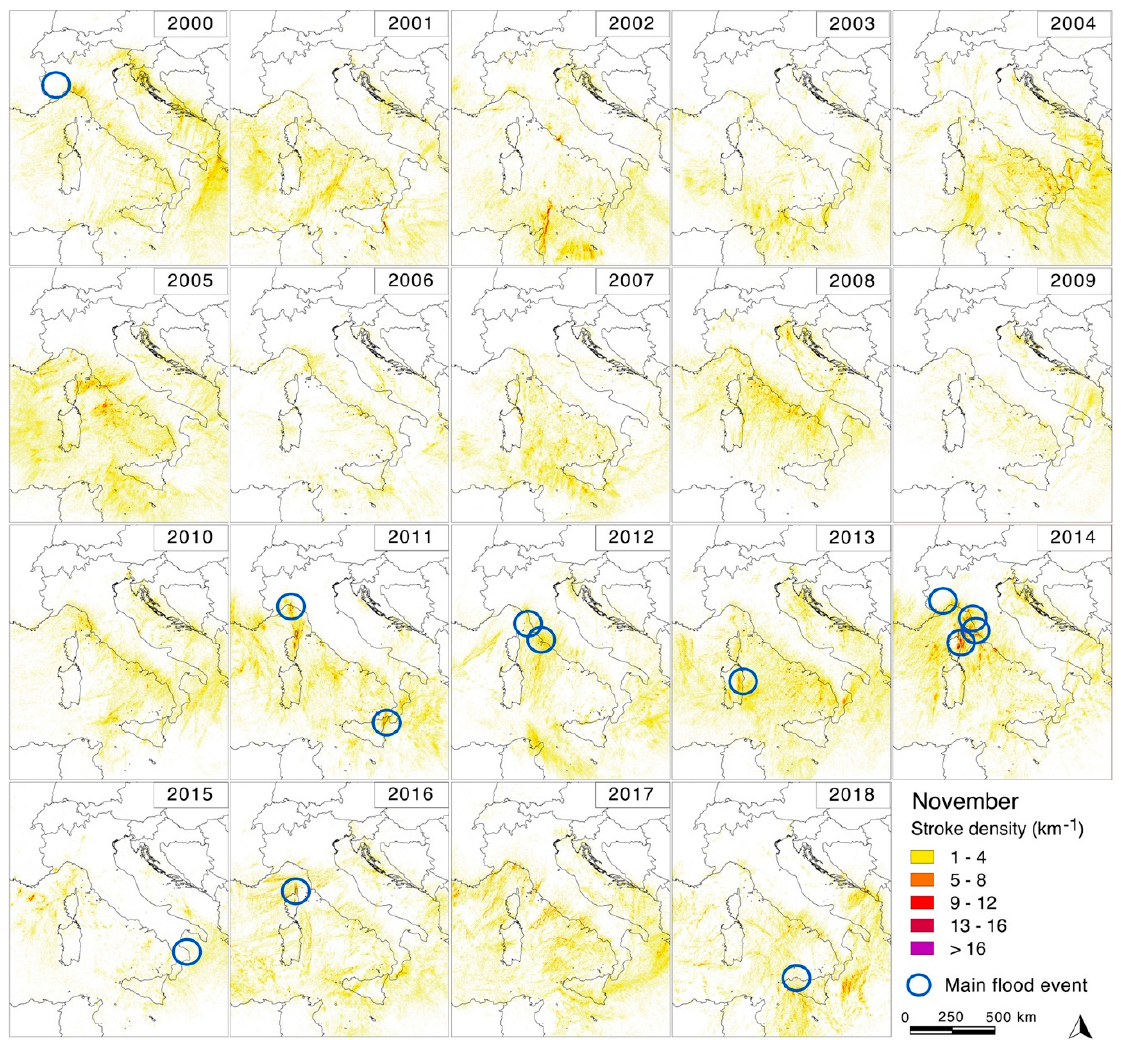
Figure 7. Cloud–ground strokes per square km in November for the entire period. Blue open circles indicate main flood events.